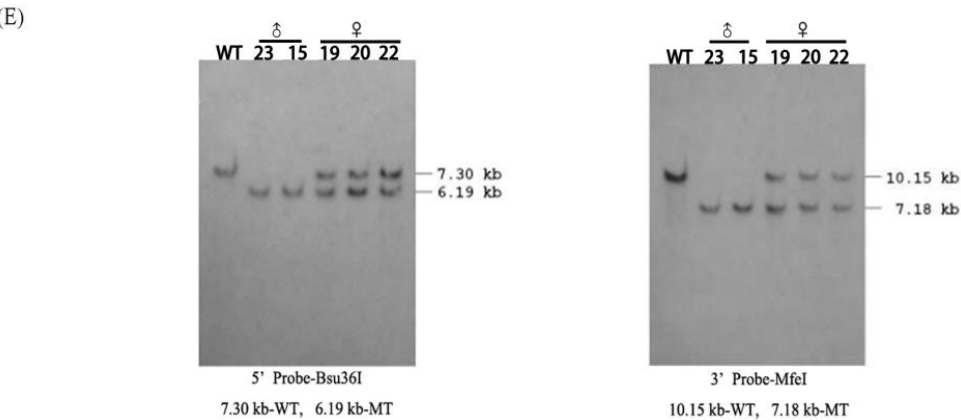
Figure 3. Production and identification of F 0 generation Rlim fl transgenic male mice and Rlim fl/+ transgenic female mice. ( A ) Schematic diagram of the production of five different types of possible F 0 -generation mice by microinjection of fertilized eggs. ( B ) Schematic diagram of primer positions for PCR identification of transgenic mice. The PCR product length of both Primer 1 and Primer 2 are 3.7 kb. ( C ) PCR identification results of F 0 -generation transgenic mice. #15, #19, #20, #22 and #23 mice were identified as F 0 generation transgenic mice. ( D ) Schematic diagram of the recognition sites of restriction enzymes and the location of DNA probes used in the Southern blotting analysis. To employ the Bsu36I site for Southern blotting analysis, an exogenous Bsu36I site was introduced between the left homologous arm and the left loxP site in the targeted allele. ( E ) Southern blot identification results in F 0 generation transgenic mice. #15, #19, #20, #22 and #23 mice were identified as F 0 generation transgenic mice. WT represents wild type and MT represents the mutant